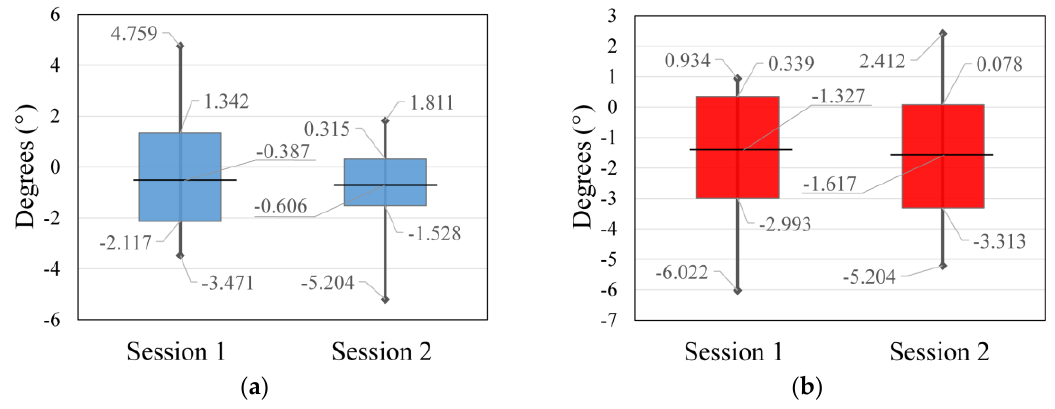
Figure 12. Display of statistical data of outdoor flight for: ( a ) pitch parameter and ( b ) roll parameter.